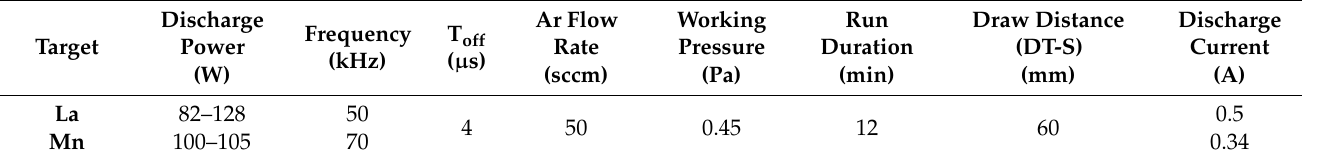
Table 1. Films deposition